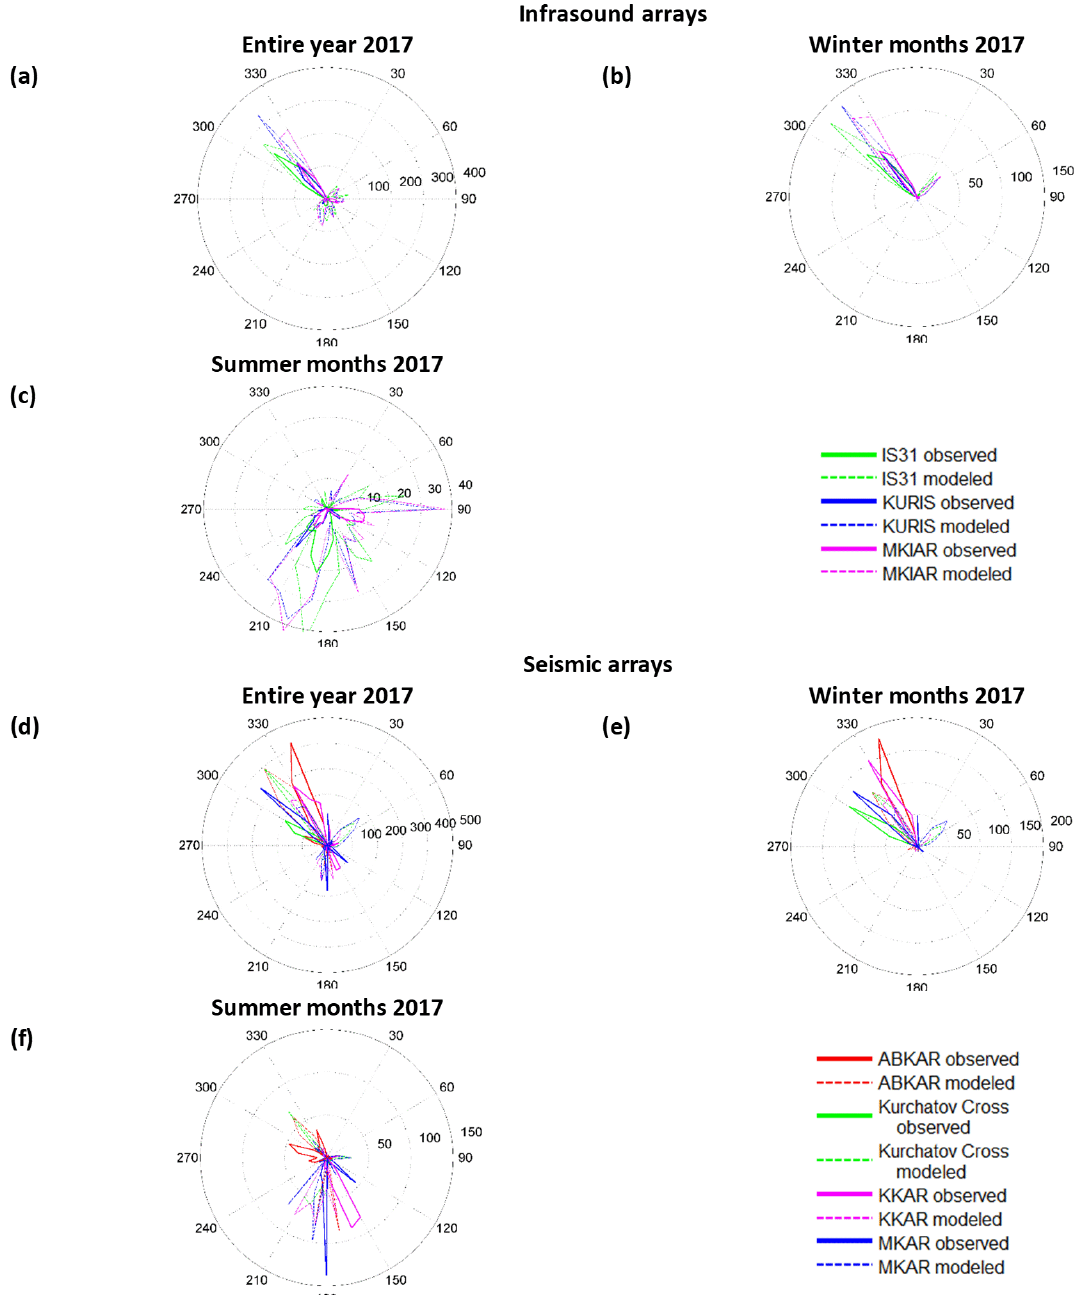
Figure D1. Azimuthal distribution of infrasound detections throughout 2017 (a) , from 1 December 2016 to 28 February 2017 (b) , and from 1 June to 31 August 2017 (c) . Azimuthal distribution of seismic detections throughout 2017 (d) , from 1 December 2016 to 28 Febru- ary 2017 (e) , and from 1 June to 31 August 2017 (f) .